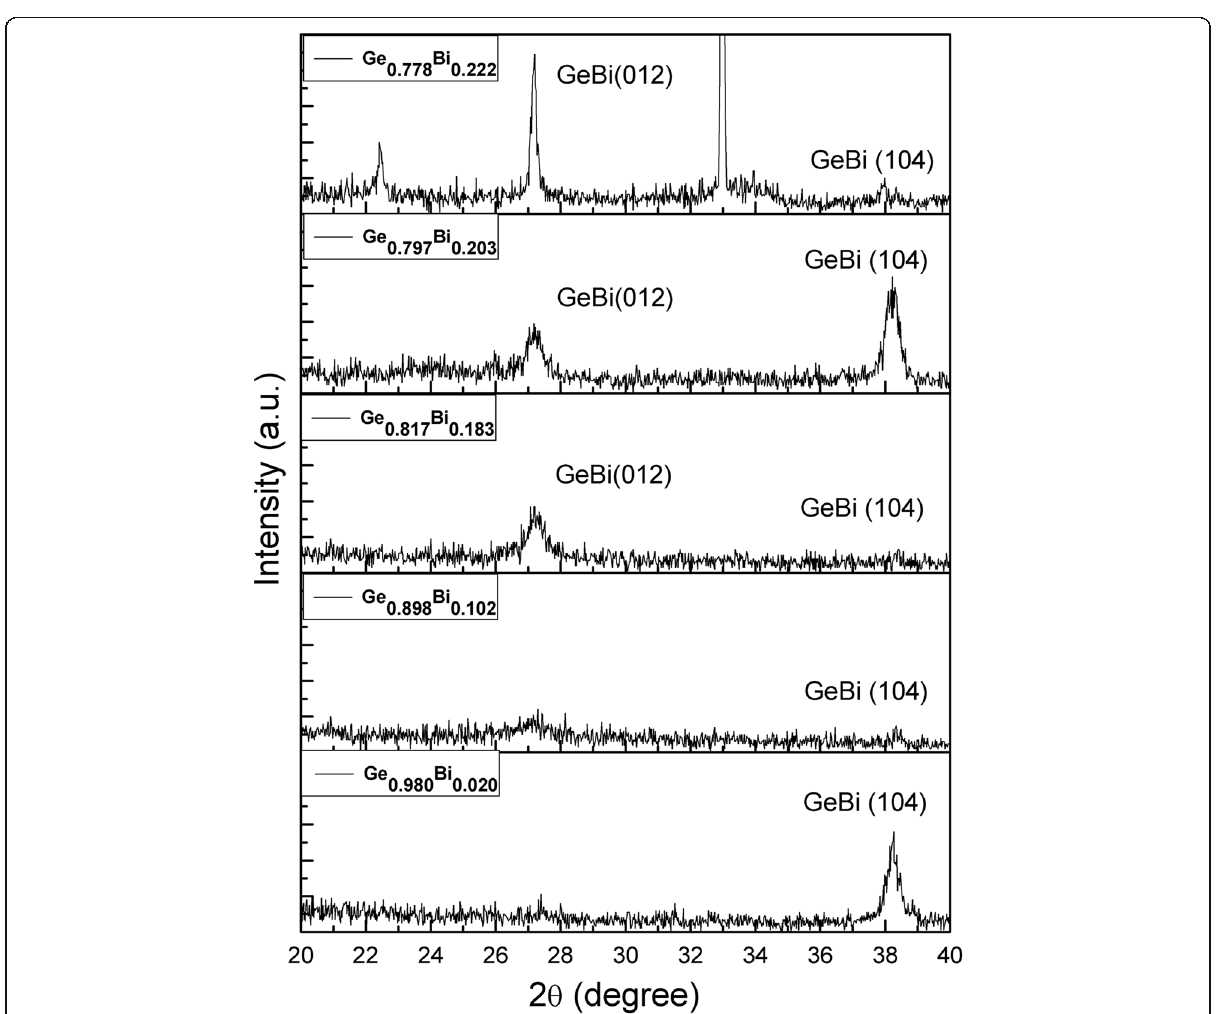
Fig. 1 XRD patterns of Ge 1 − x Bi x film GeBi films with different Bi contents ranging from x = 0.020 to x =